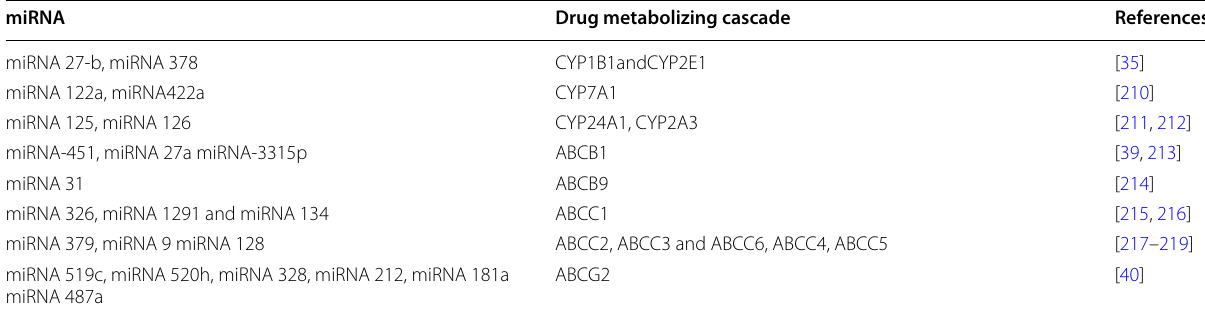
Table 1 The association of miRNA with the drug metabolising cascade miRNA Drug metabolizing